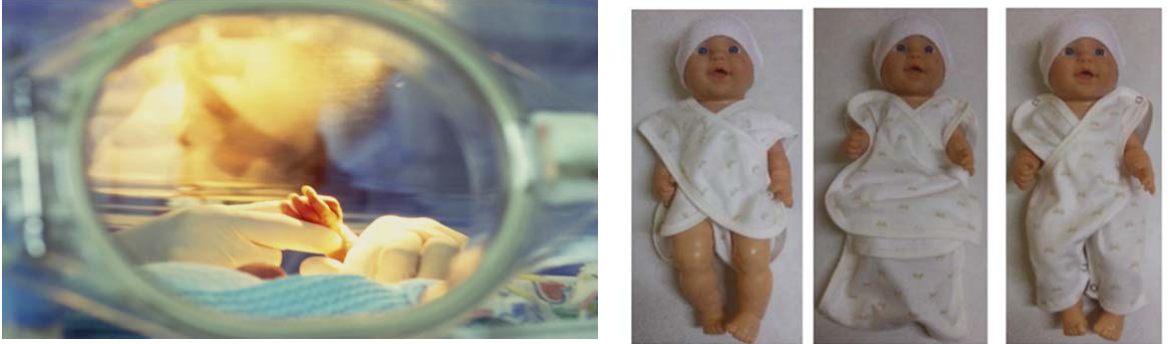
Figure 2 . Clothes for premature babies in therapy own